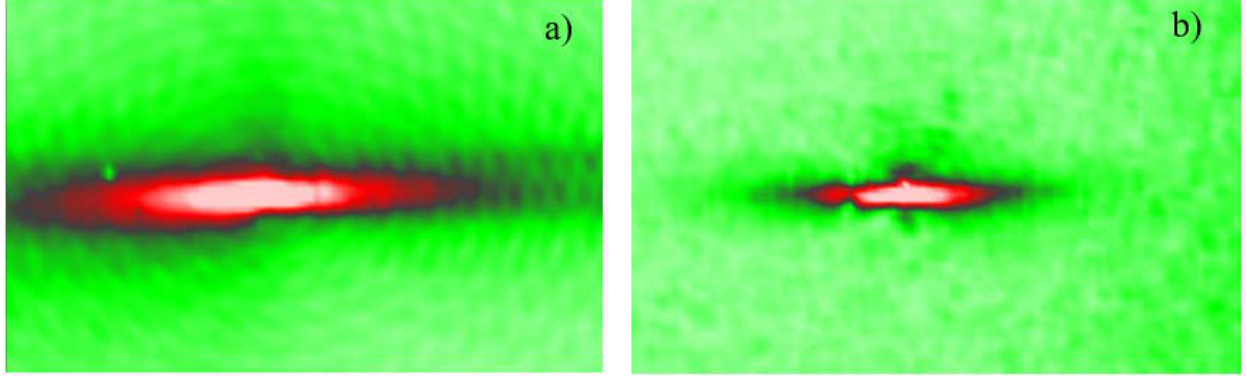
Figure 16. Phonon focusing of a 0 modes in UD-CFRP: ( a ) ( f · D ) = 175; ( b ) ( f · D ) = 500. The fibre direction is horizontal.